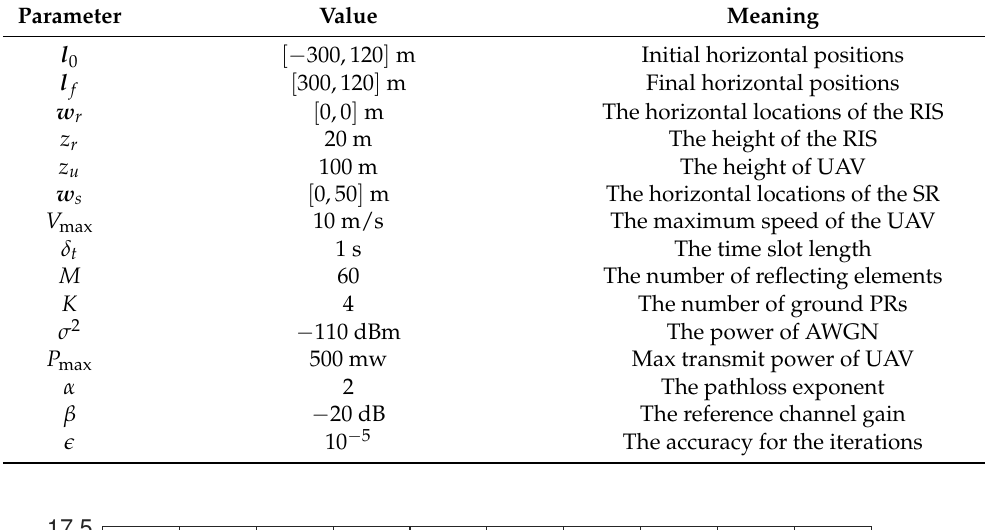
Table 2. The major system parameters used in the paper.